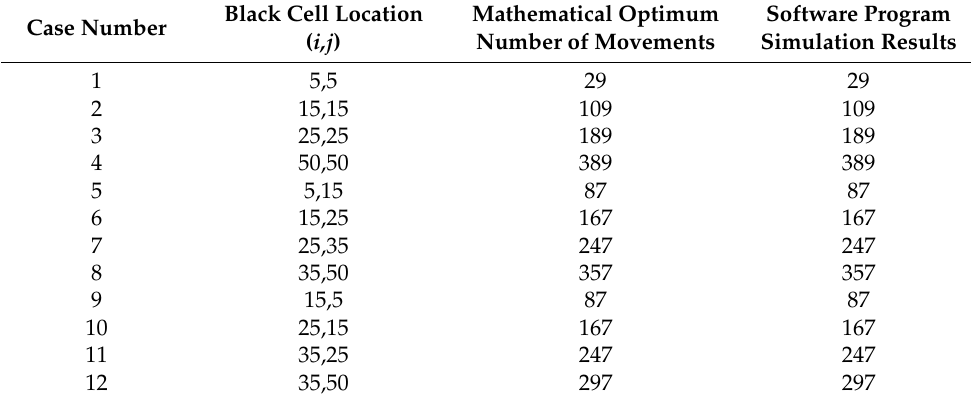
Table 2. Comparison of our results with the optimum mathematical solution obtained by [6]. Case